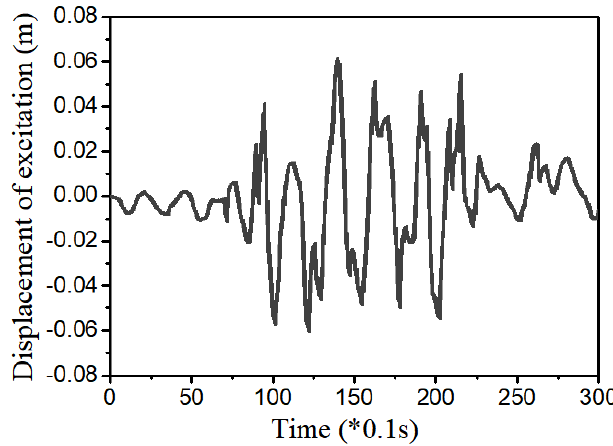
Figure 12. Power spectral density of the proposed control system under random bump road excitation.